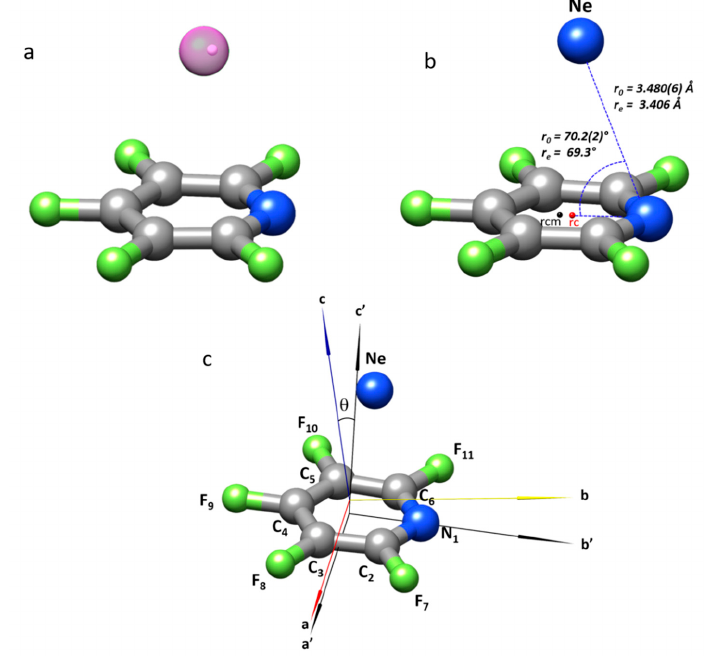
Figure 2. The structure of F 5 PY-Ne adduct: ( a ) The CCSD/6-311++G(2d,p) predicted structure is drawn with a translucent Ne atom to show the location of the Ne atom (white small sphere) according to the r s coordinates. ( b ) The structure gives the values of the r 0 and r e (MP2/aug-cc-pVTZ) van der Waals bonding parameters. ( c ) The location of the F 5 PY and F 5 PY-Ne inertial axes is shown together with the definition of the angle θ . rcm is the F 5 PY center of mass and rc is the ring centroid.